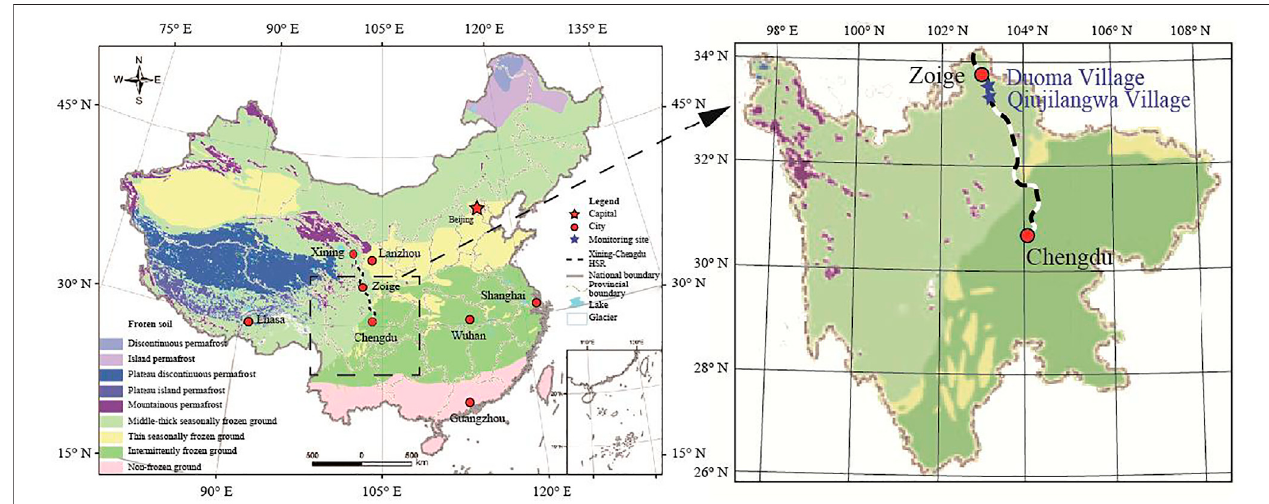
FIGURE 1 | Frozen ground distribution in China and the monitoring site along the Xining-Chengdu HSR.